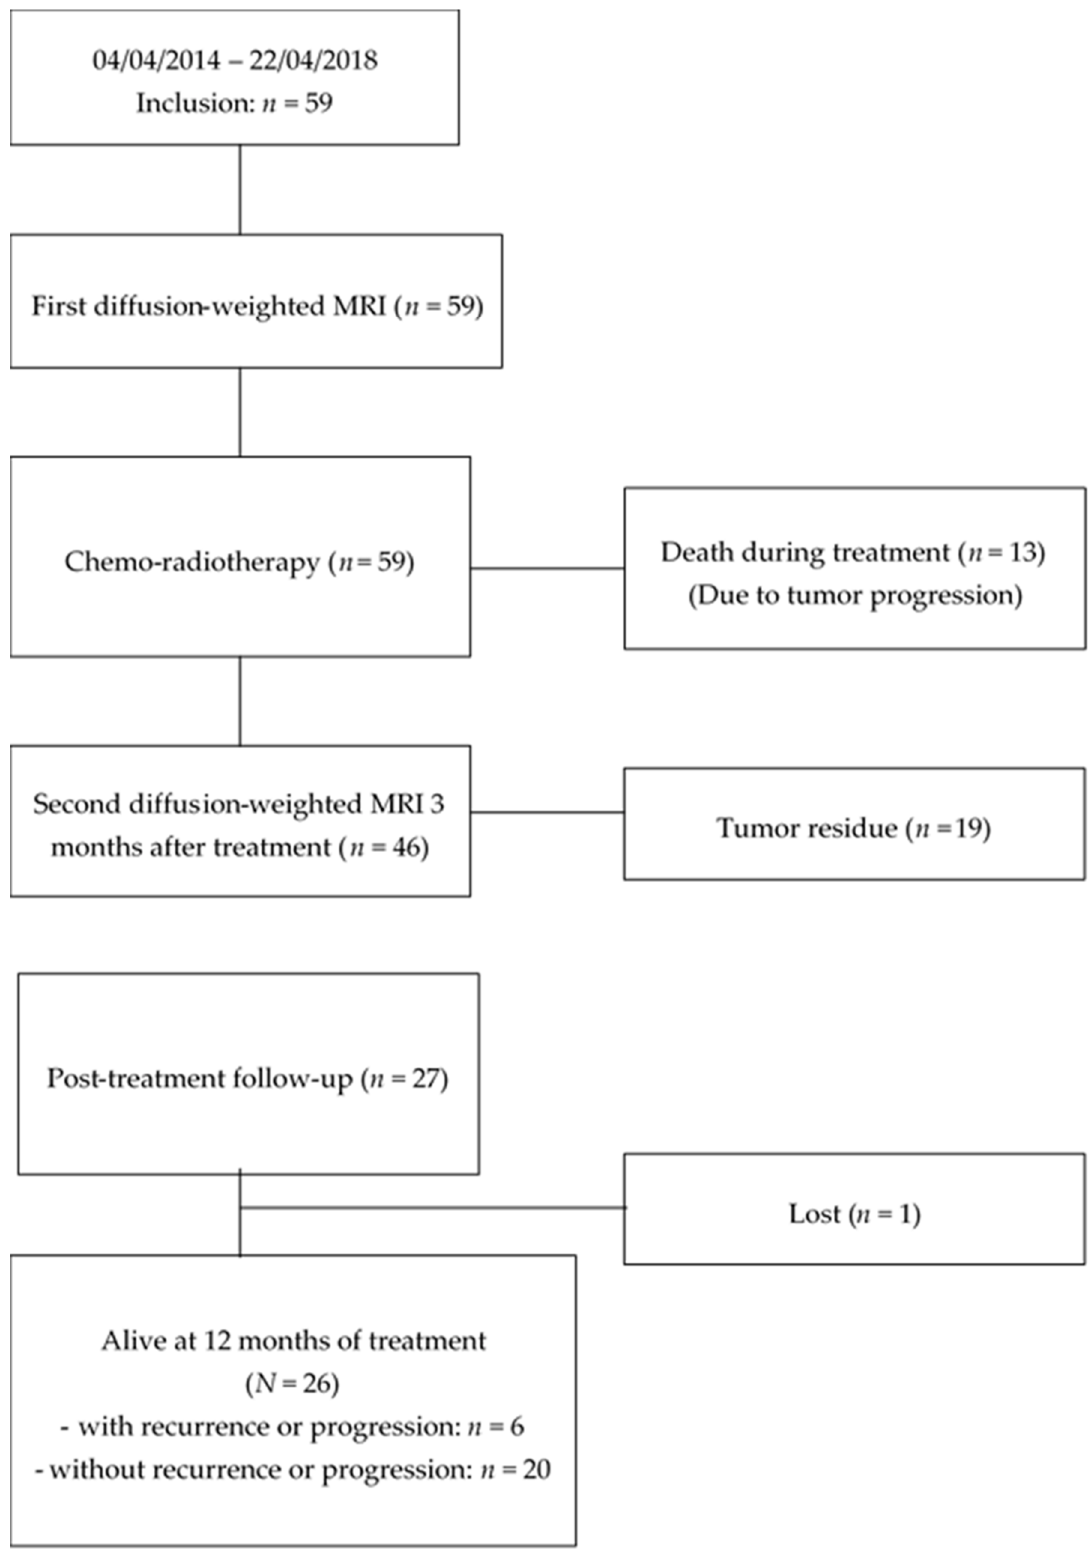
Figure 2. Flow-chart of the study.